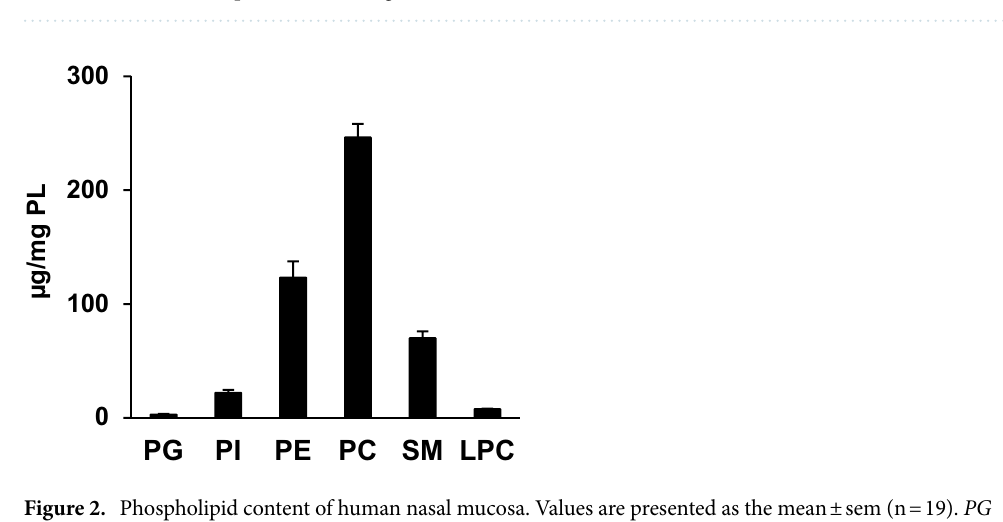
Figure 1. Box plot representation of fatty acid levels in human nasal mucosa . The results are presented as the median, first and third quartiles, and range (n = 20).